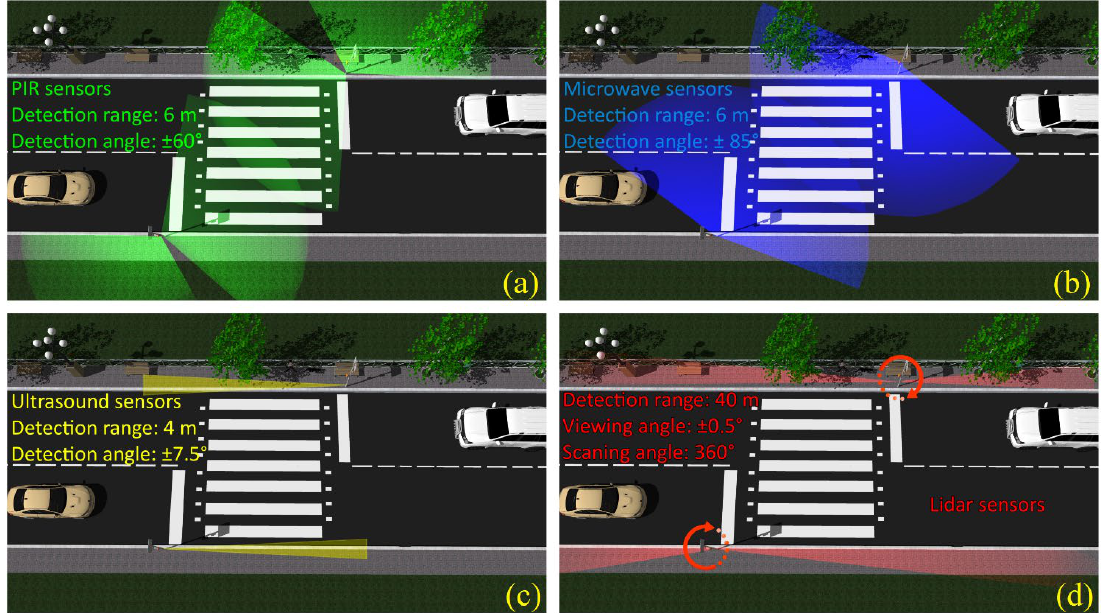
Figure 3. Schematic of the pedestrian presence and localization unit sensors and their coverage area information: ( a ) PIR sensors; ( b ) microwave sensors; ( c ) ultrasound sensors; ( d ) LIDAR sensors.